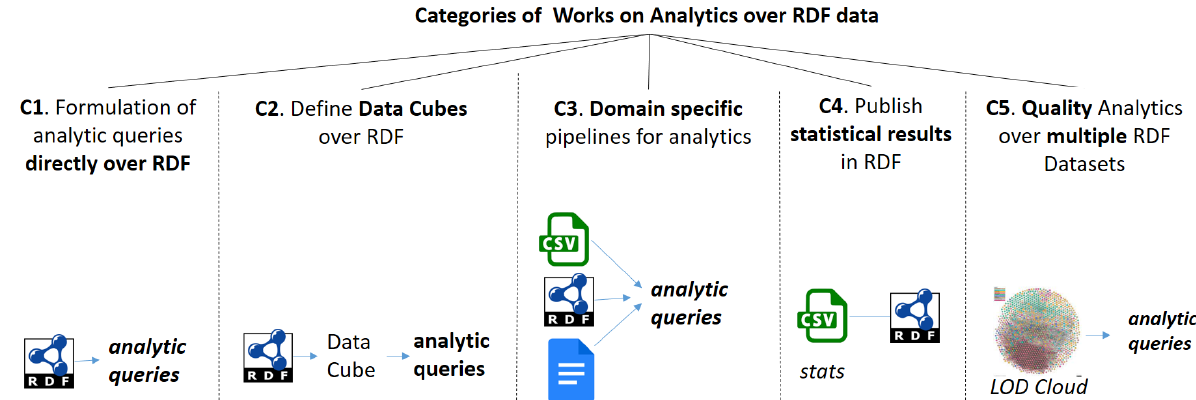
Figure 5. The spectrum of related works in 5 different